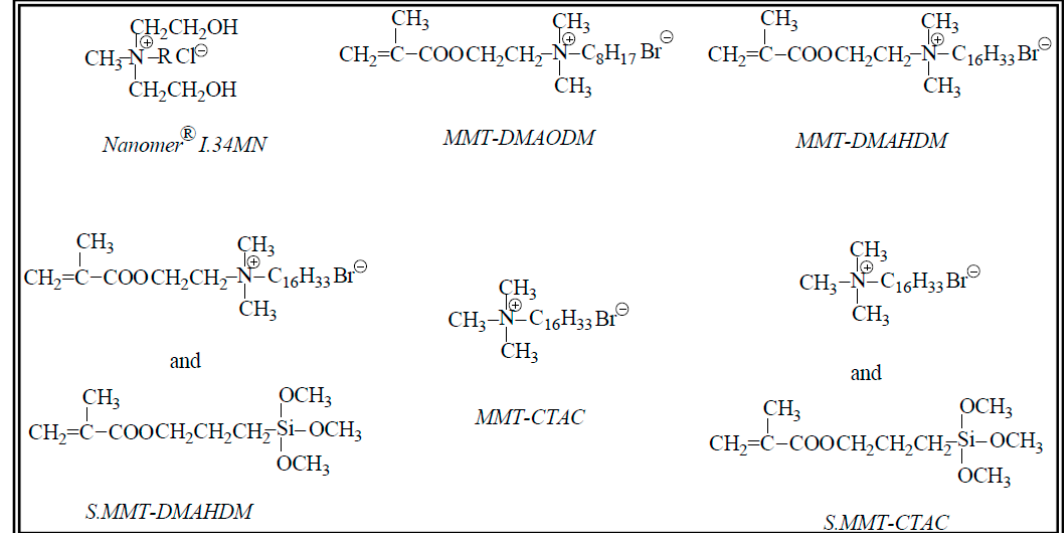
Figure 1. Different types of clay organomodifiers used for nanocomposite synthesis (R stands for hydrogenated